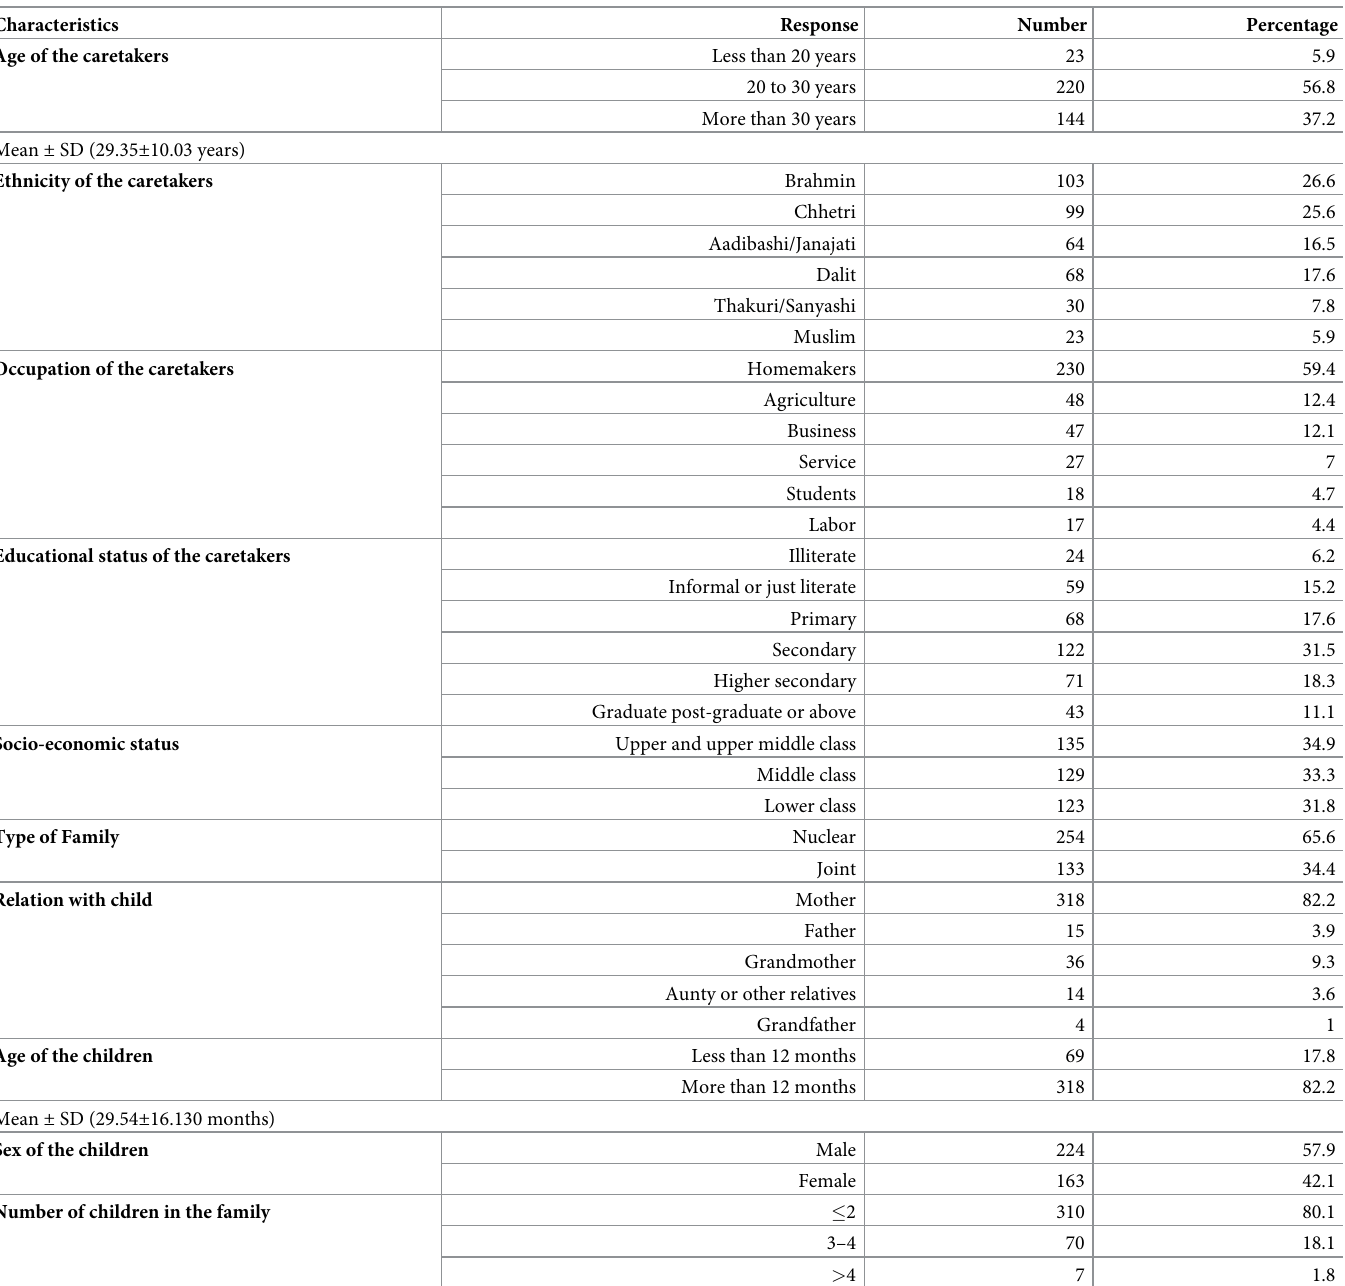
Table 1. Socio-demographic characteristics of the caretakers and children n =